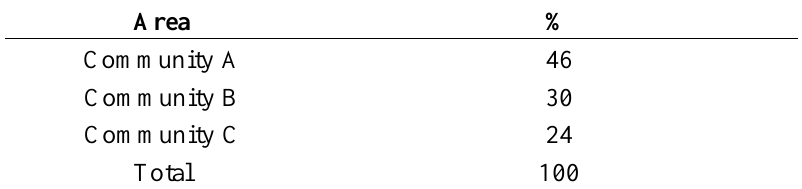
Table 1. Sample captured for this survey (%) (n = 2,196).